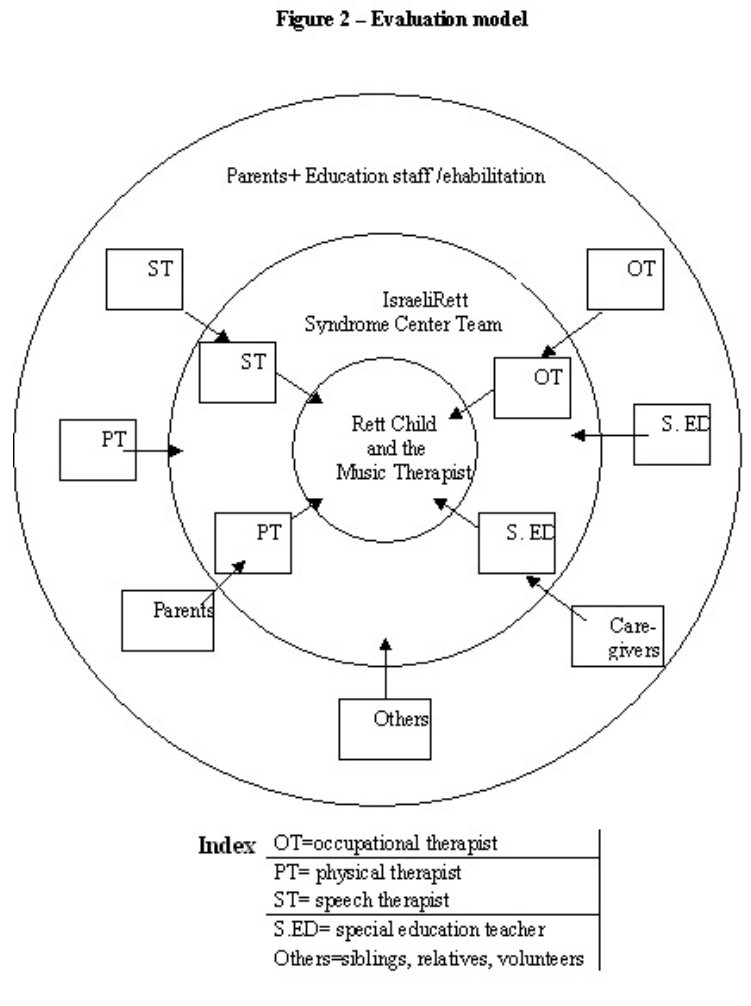
FIGURE 2 . Evaluation